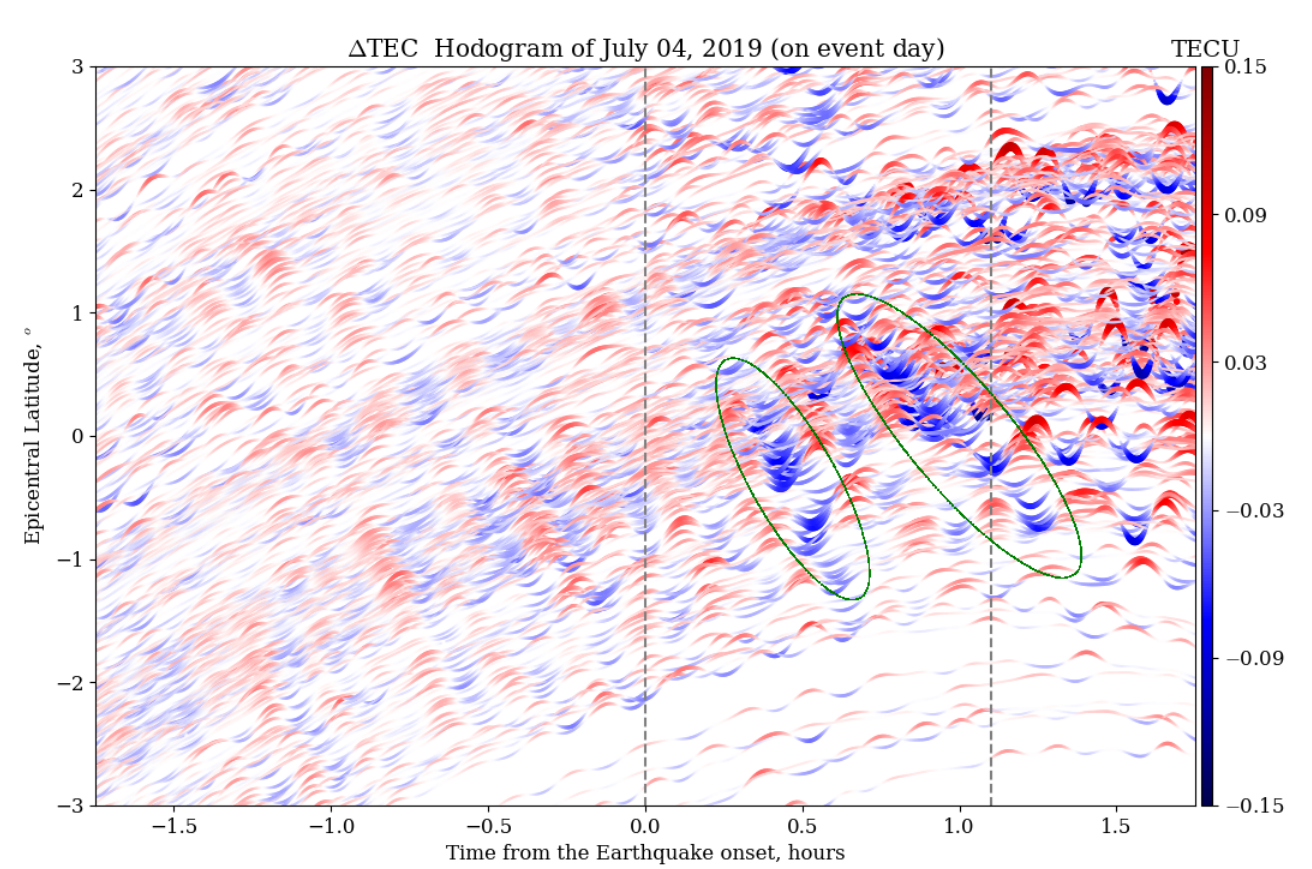
Figure 6. Hodogram of observed ∆ TEC on the earthquake